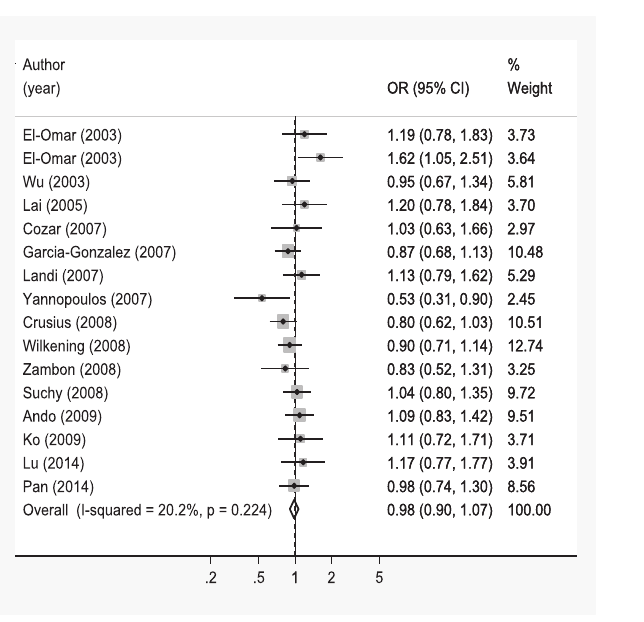
Fig. 2. Forest plotof gastrointestinal cancer risk associatedwith IL4 rs2243250 (Tallele vs. C allele). CI, con fi dence interval; OR, odds ratio.